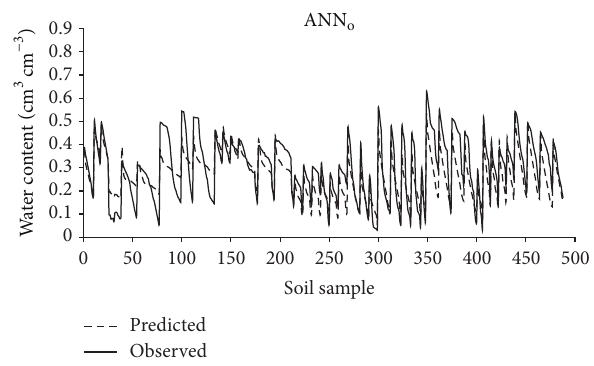
Figure 5: Observed and predicted water contents obtained by ANN o for soils from the verification